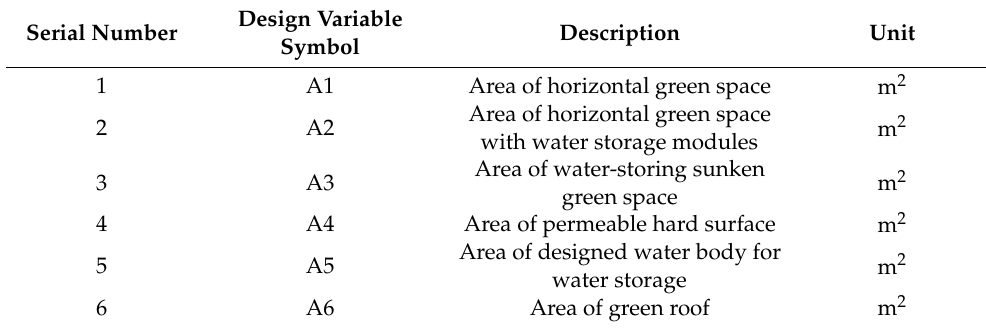
Table 3. Composition of variables for a multi-objective optimization model for sponge facilities